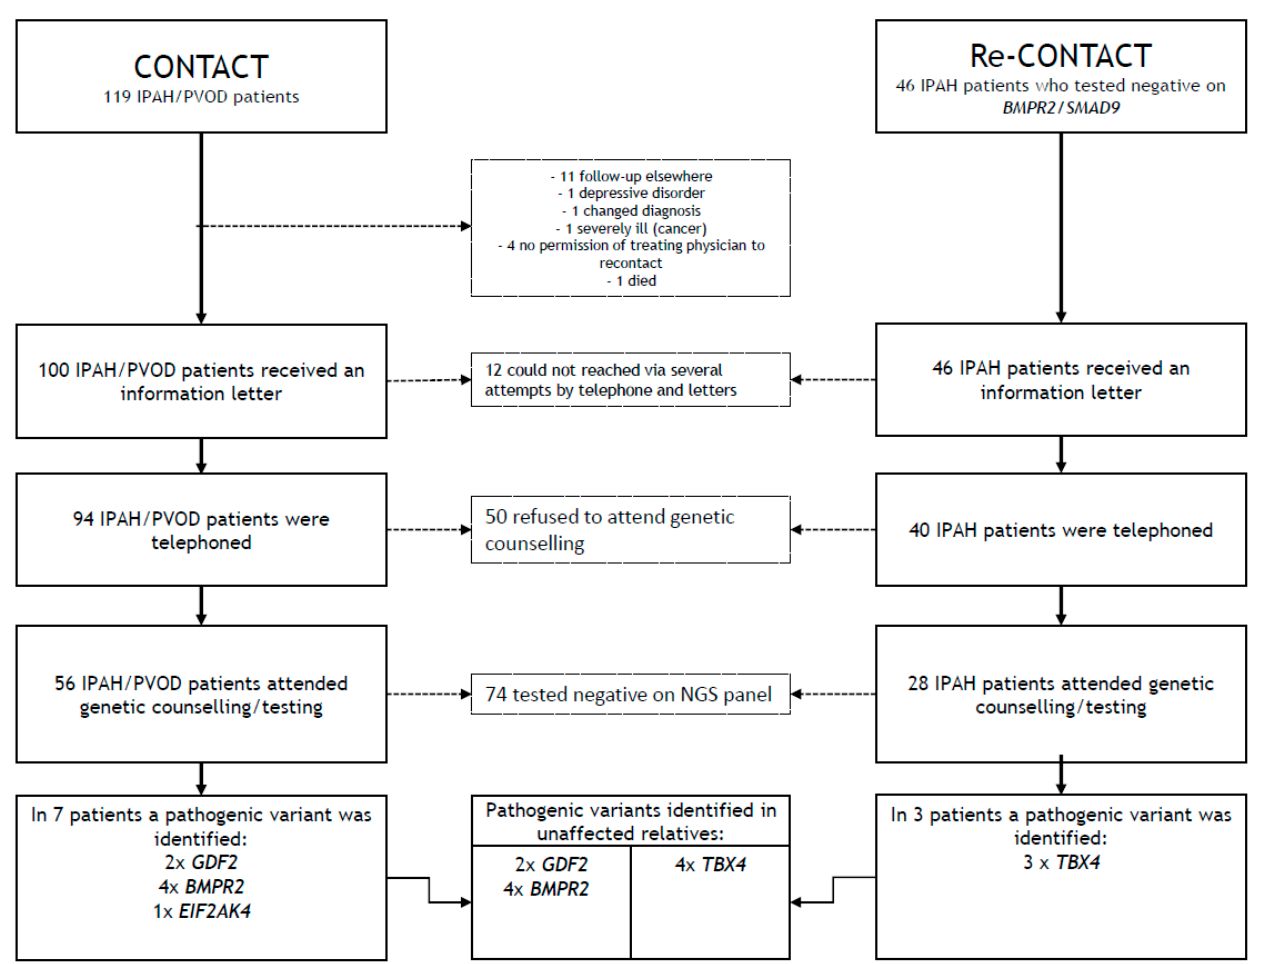
Figure 2. Flowchart of the (re-)contact approach with patient inclusion and results of genetic testing. The (re-)contact approach consisted of iPAH/PVOD patients who were not previously genetically tested (CONTACT group) or who tested negative on prior analysis of the BMPR2 and SMAD9 genes (Re-CONTACT group). iPAH: idiopathic pulmonary arterial hypertension, PVOD: pulmonary veno-occlusive disease, NGS: next-generation sequencing.